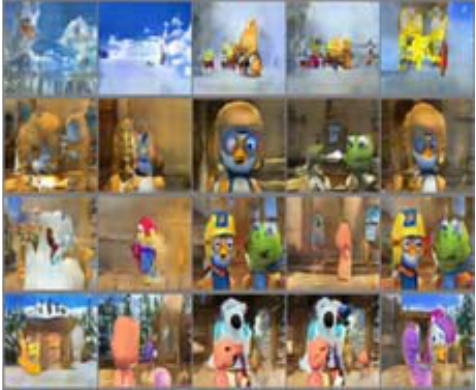
Fig. 4.6. Stage I Low Resolution Image Fig. 4.7. Stage II High Resolution